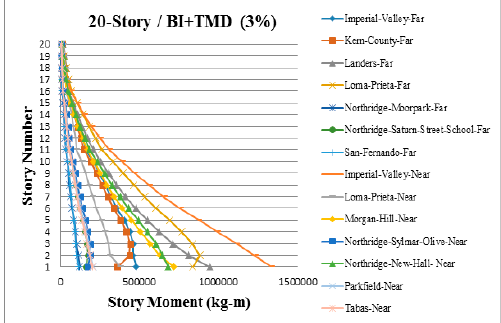
Figure A26. Peak story moments for 20-story base-isolated building with 1 TMD.